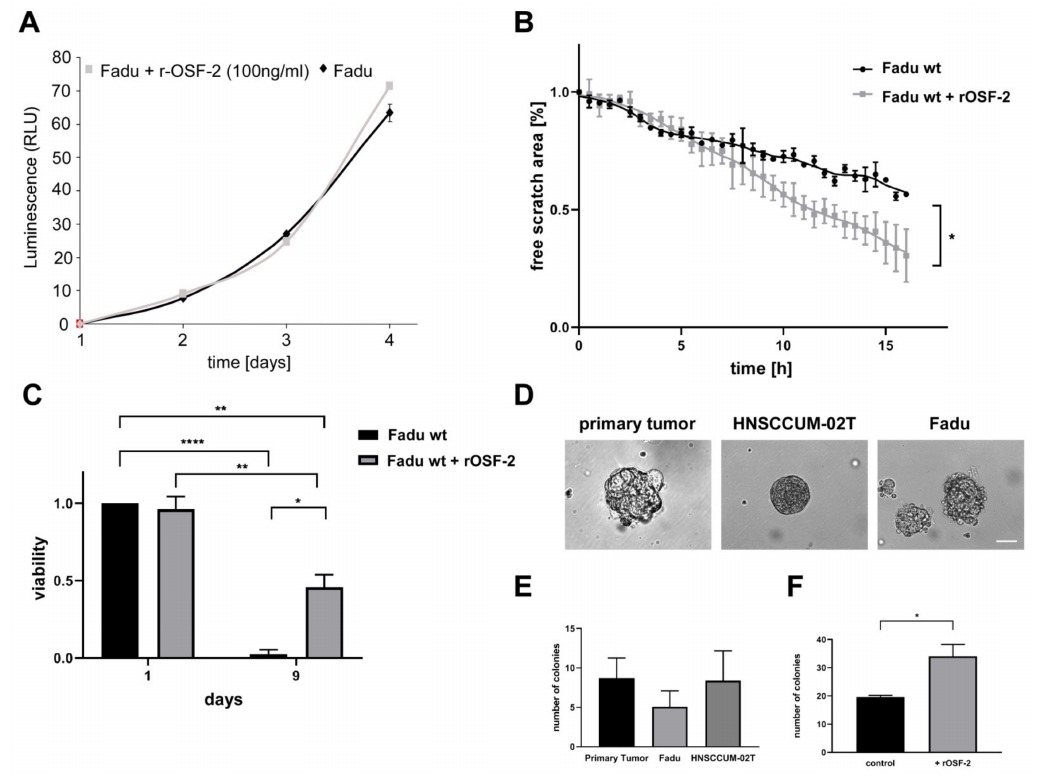
Figure 7. OSF-2 promotes cell migration and cellular survival under stress conditions. Administration of recombinant OSF-2 (100 ng/mL) did not affect HNC cell (FaDu) proliferation ( A ), but resulted in increased cell migration ( B ), and improved survival under serum deprivation ( C ). ( D , E ) Spheroid and colony formation assays revealed clonogenicity of three OSF-2 overexpressing HNC cell lines (controls without treatment). Scale bar, 100 µ m. ( F ) Presence of recombinant OSF-2 increases the number of formed colonies using Fadu cells. p -values of unpaired t -testing as indicated. * p < 0.05, ** p < 0.01, **** p <